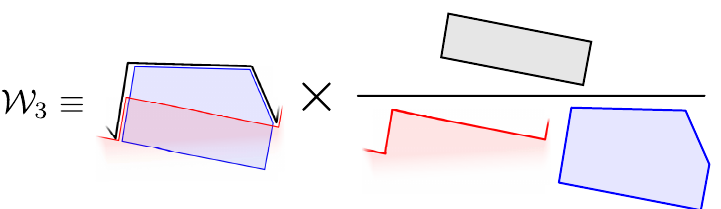
Figure 2 . A finite conformally invariant ratio is constructed by dividing the three-sided wrapped polygon by the pentagon and the two-sided wrapped polygon and multiplying by the square on which these two objects overlap, W 3 = h W 3 -pt ff i×h W square i h W 2 -pt ff i×h W pentagon i